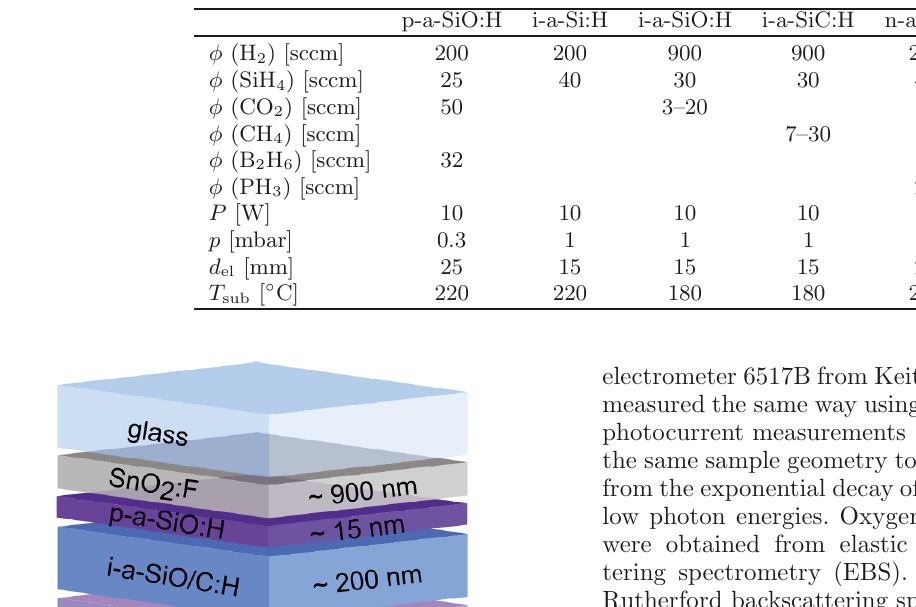
Table 1. Summary of the deposition parameters used in this work.